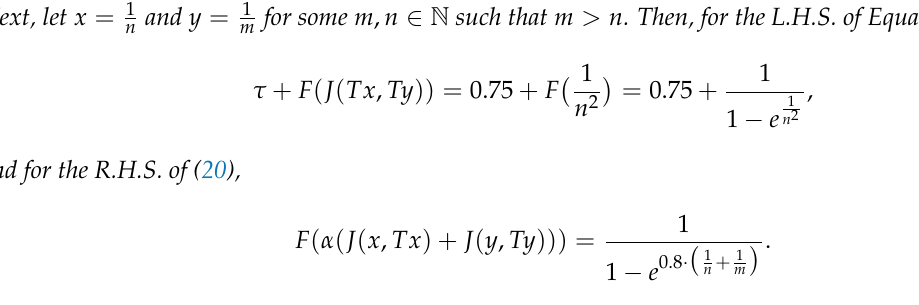
Figure 2. The value of comparison of the L.H.S. and R.H.S. of Equation (20) in the 3D